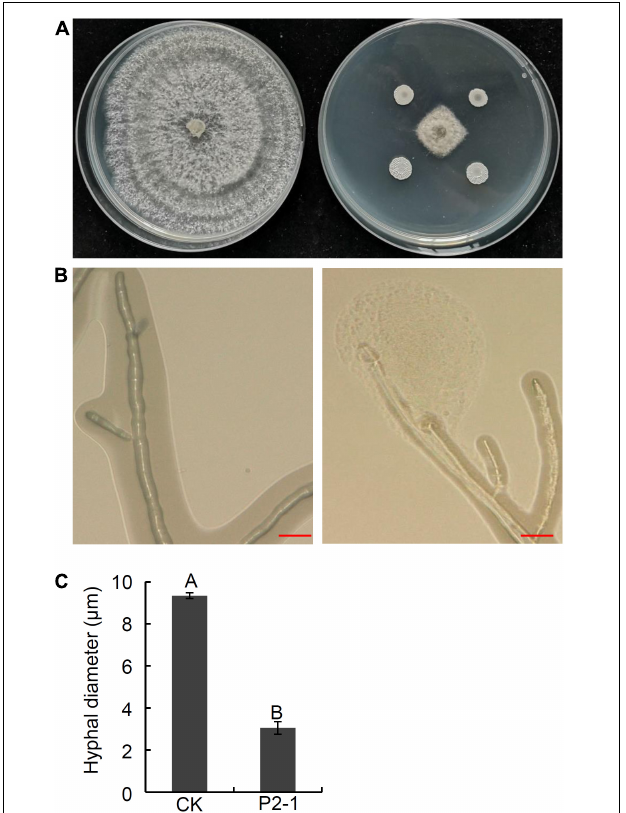
FIGURE 1 | Inhibition of strain P2-1 on hyphal growth of B. dothidea . (A) Antifungal activity of strain P2-1 against B. dothidea . Left: B. dothidea CK; Right: B. dothidea at the present of strain P2-1. The pictures were taken at 6 days after inoculation. (B) Effect of strain P2-1 on hyphal morphology of B. dothidea . Left: B. dothidea CK; Right: B. dothidea at the present of strain P2-1. The picture was taken at 2 days after antagonism with strain P2-1 using an ultra-depth three-dimensional microscope. Bar = 20 µ m. (C) Hyhal diameter of B. dothidea after antagonism with strain P2-1. Values are means ± SD from three replicates. Different letters indicate significant differences between different treatments according to Student’s t -test ( P < 0.01).